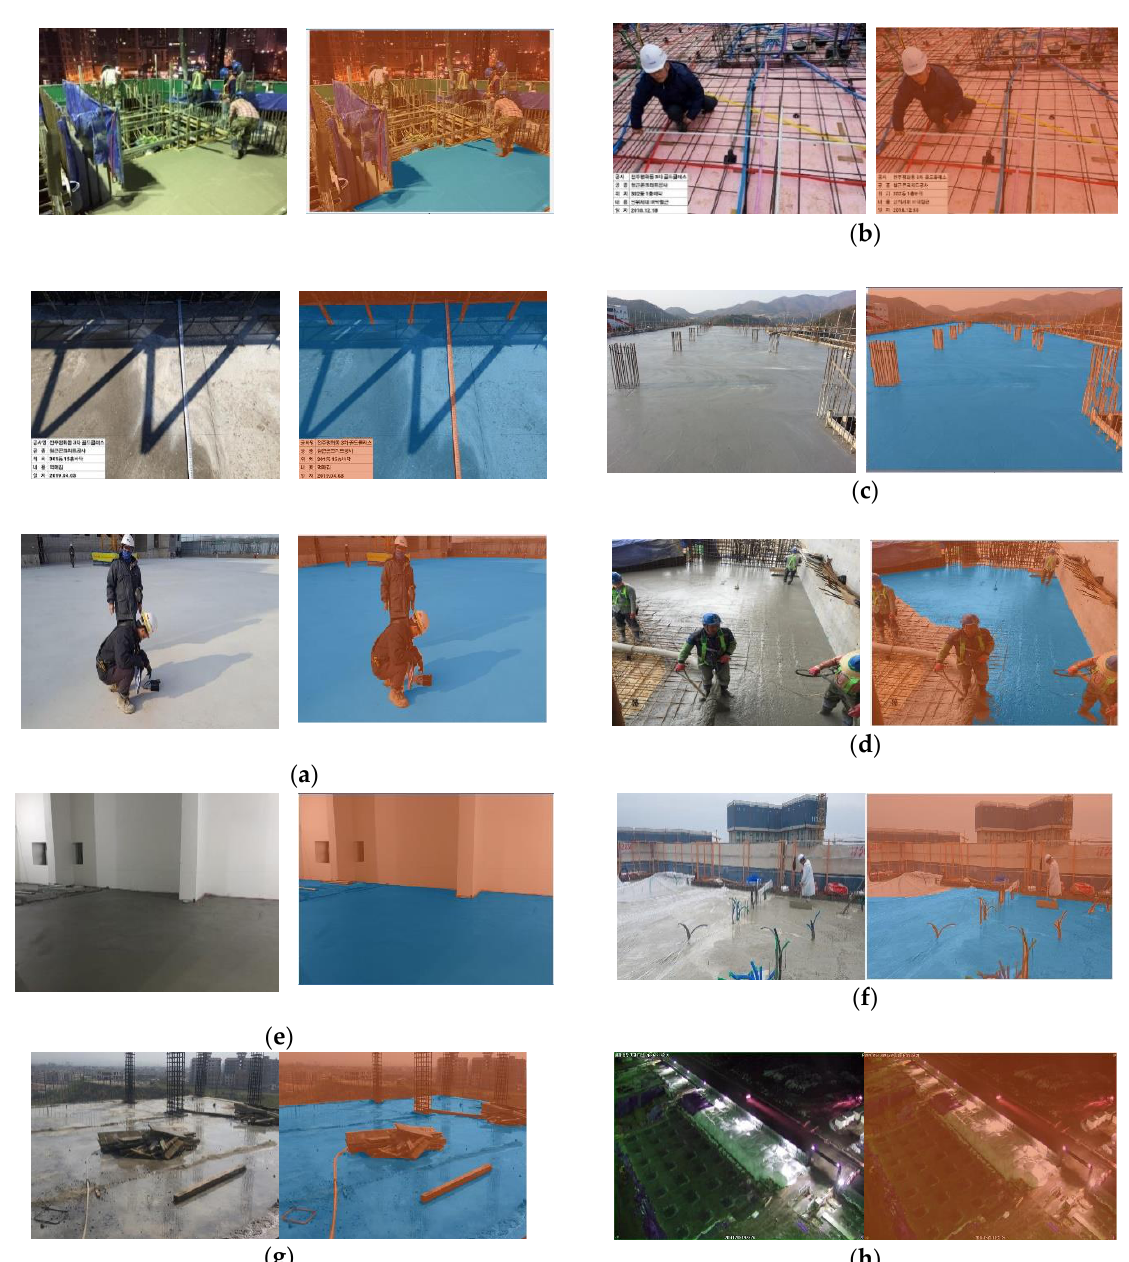
Figure 1. Examples of criteria of pixel-based labeling for construction site images (original: left; labeled: right; red: nonconcrete; blue: concrete): ( a ) Every concrete area was labeled, even the shadows and the dark spots. ( b ) The whole image was labeled as ‘not concrete’ since there were no traces of concrete. ( c ) The reinforcement bars were avoided as much as possible. ( d ) The people were omitted. Moreover, the fresh concrete below reinforcements was also omitted. ( e ) Only the fresh and young concrete was labeled as concrete. Old concrete and concrete covered by paint was omitted. ( f ) When the concrete was covered with a transparent sheet, the areas where the sheet was in contact with concrete were labeled as ‘concrete’. ( g ) Wet regions or concrete covered with water was also labeled as ‘concrete’. ( h ) When the area covered with concrete was in an extreme darkness, it was labeled as ‘ nonconcrete ’ .